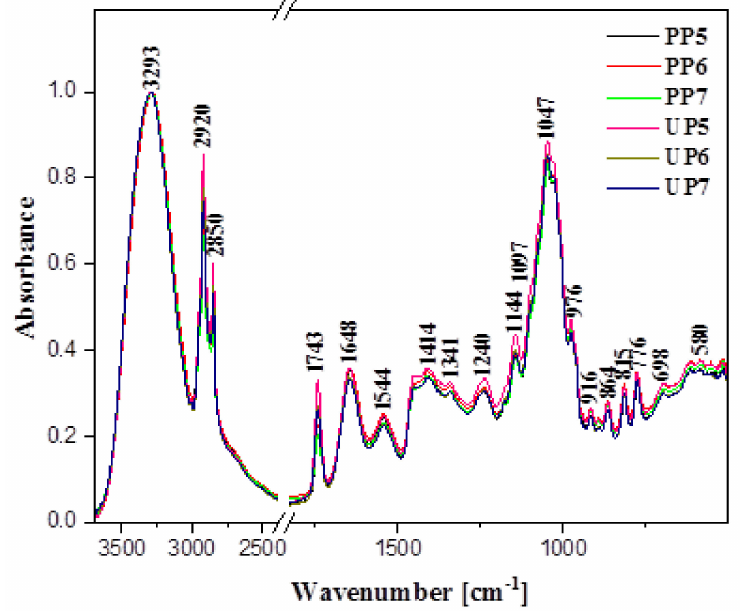
Figure 2. Fourier transform infrared FTIR spectra of ice cream samples subjected to UP ultra- sound pasteurization and traditional PP pasteurization, presented in the spectral range from 3600 to 550 cm − 1 normalized at 3293 cm − 1